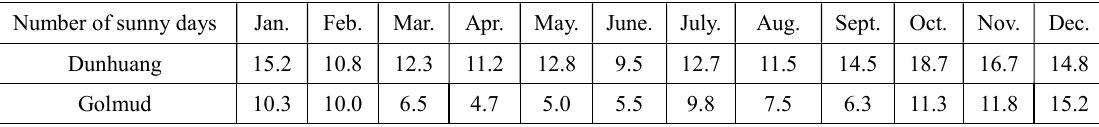
Table 9 Average number of sunny days per month in different